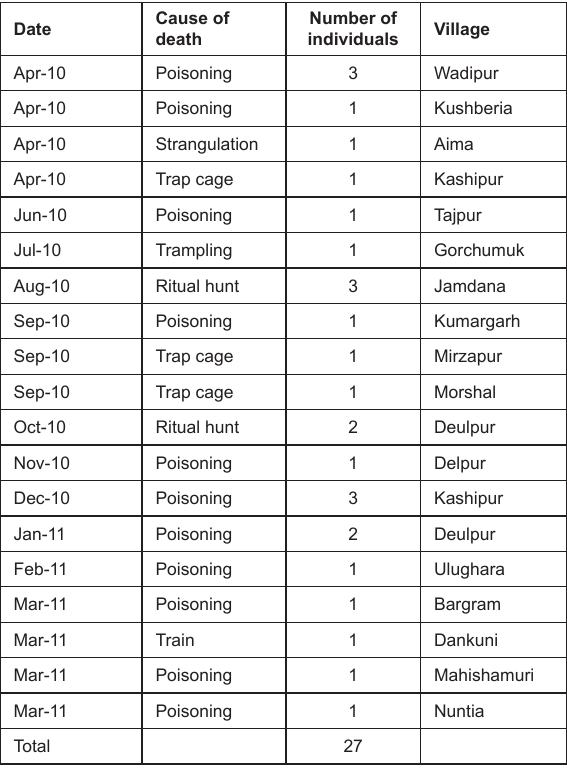
Table 3. List of dead Fishing Cats encountered during the study